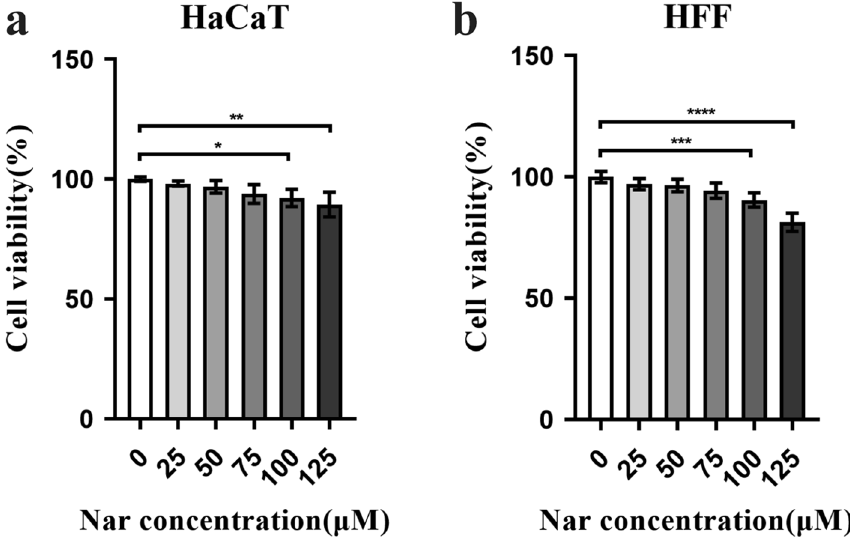
Figure 6. Effect of naringenin on the viability of HaCaT cells ( a ) and HFFs ( b ). After treatment with naringenin for 24 h, the viability of these cells was measured. For all studies, n ≥ 3. Error bars show the means ± SDs. Bar chart data were compared by ANOVA. * P < 0.05, ** P < 0.01, *** P < 0.001, and **** P <